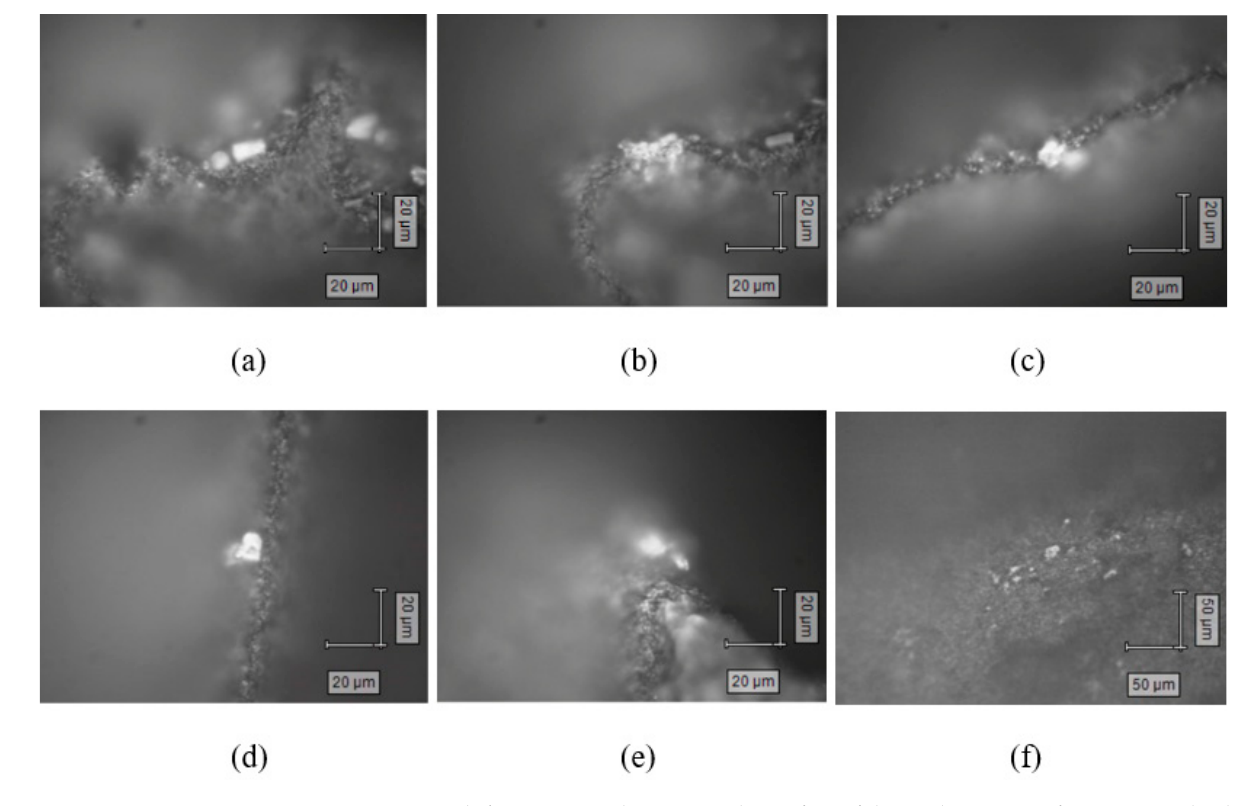
Figure 4. Crystals/precipitates showing on the surface of the media in water for 30 min and 3 days at 6 °C: ( a ) 30 min raw MnOx—CaSO 4 precipitates; ( b ) 30 min raw MnOx-sample 785 with CaCO 3 ; ( c ) FA 30 min’ ( d , e ) 3-day raw MnOx—CaCO 3 ; ( f ) HA day 3.